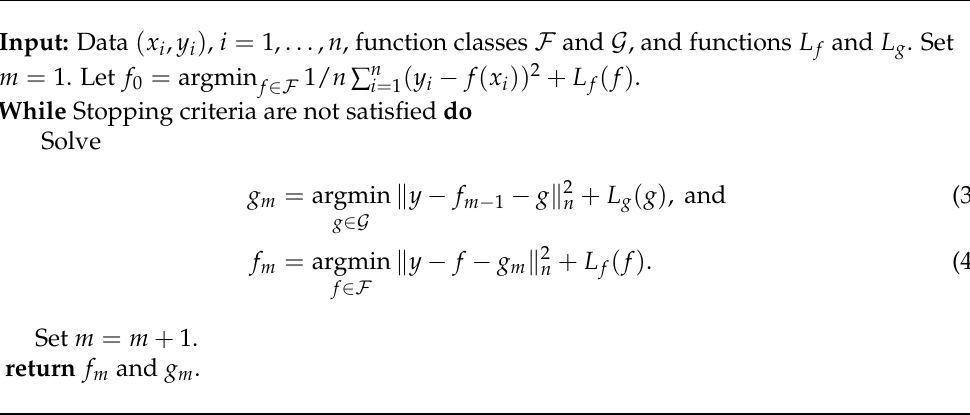
Algorithm 1 Iterative